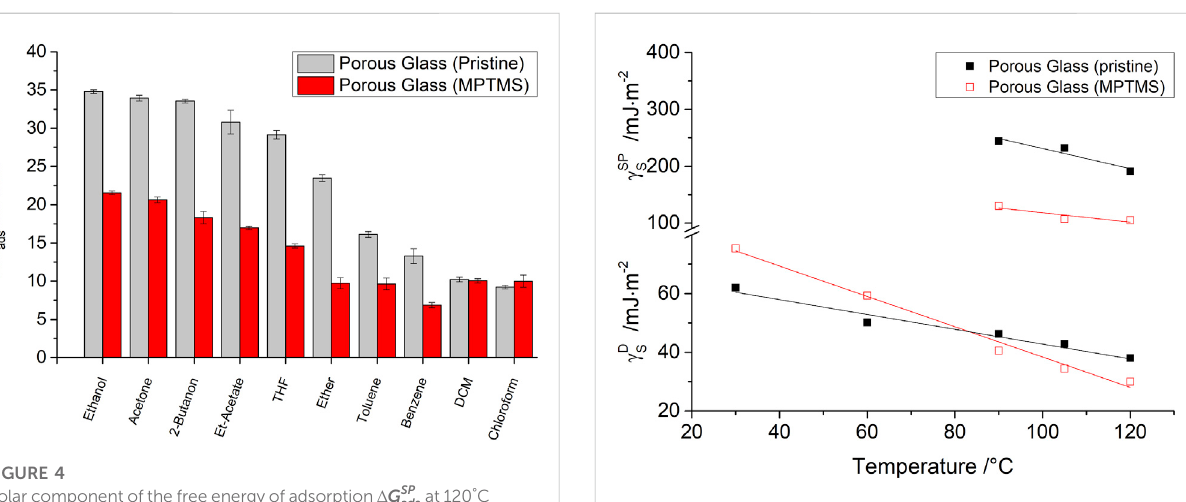
FIGURE 5 Dispersive γ D S and speci fi c γ SP S components of the free surface energyasafunctionoftemperatureformacro-poroussilicabefore( ■ ) and ( □ ) after surface modi fi cation with